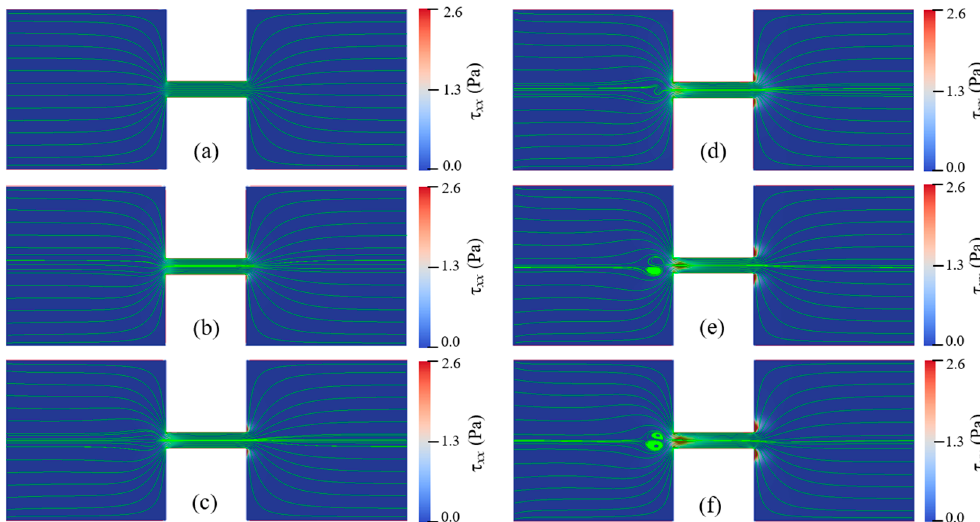
Figure 13. Streamlines for 150 ppm PAA solution under different E app at 1.78 s: ( a ) 100 V/cm, ( b ) 200 V/cm. ( c ) 300 V/cm, ( d ) 400 V/cm, ( e ) 500 V/cm, ( f ) 600 V/cm. The color bar represents the elastic normal stress τ xx .